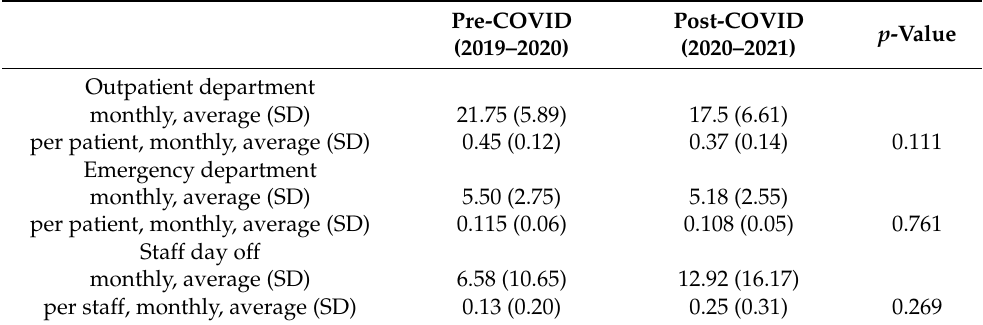
Table 3. Difference between the pre- and post-COVID 19